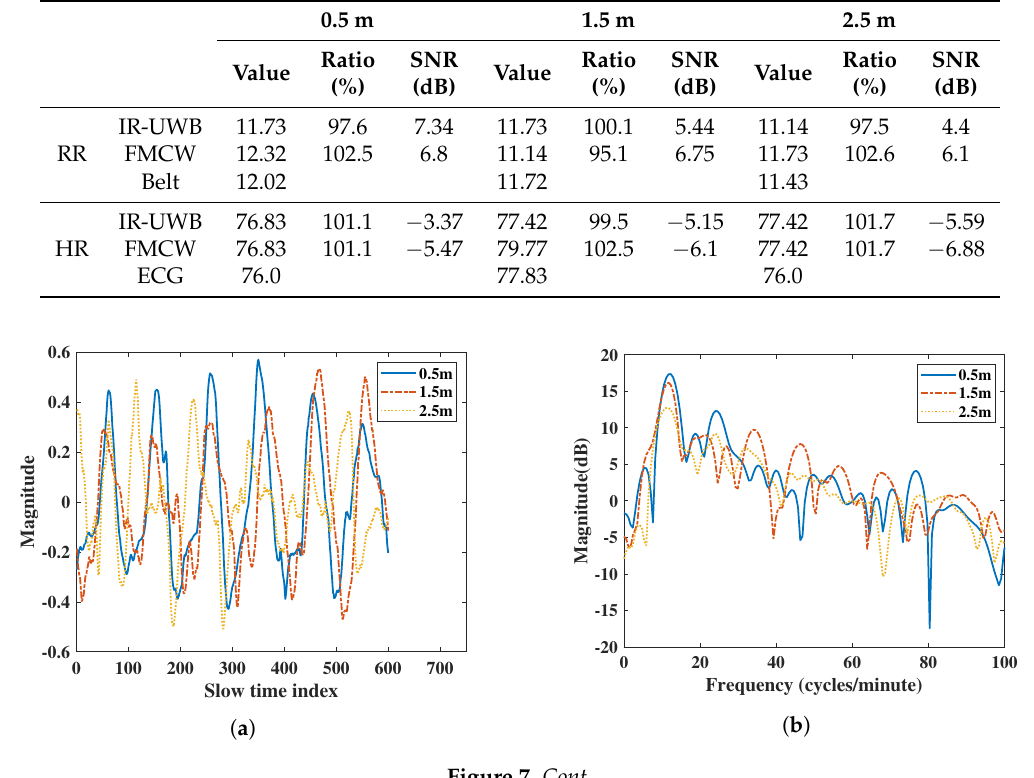
Table 4. RR and HR Results from the distance-based